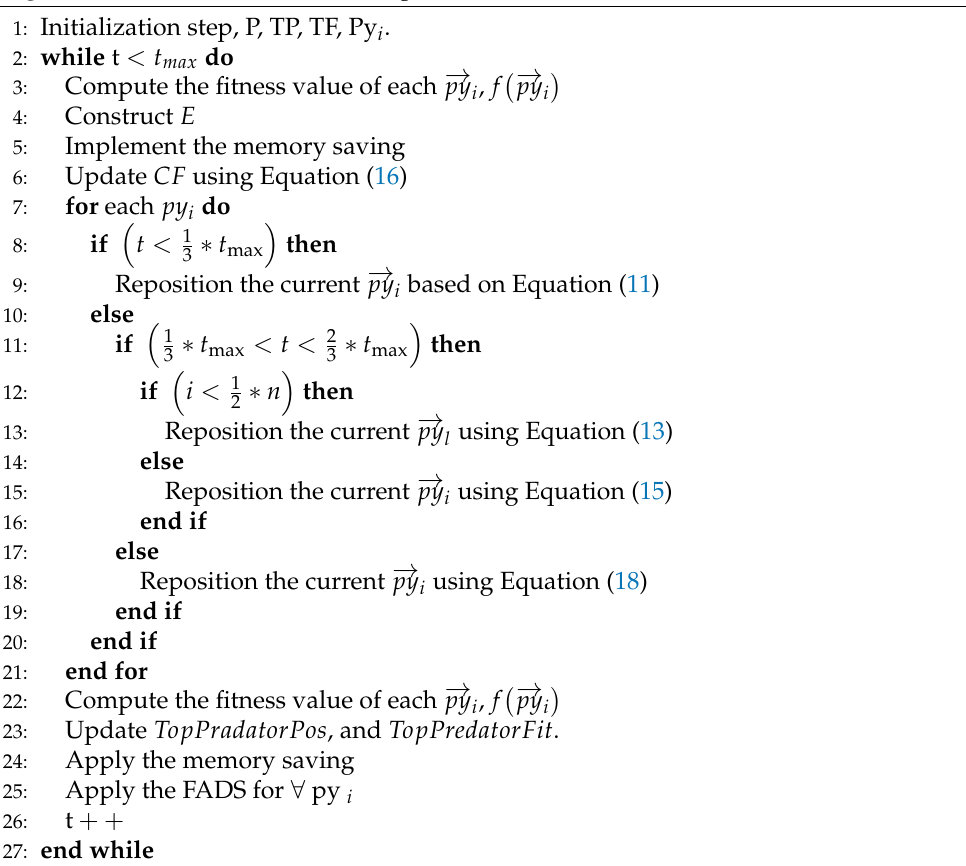
Algorithm 1 Pseudo-code of MPA algorithm.